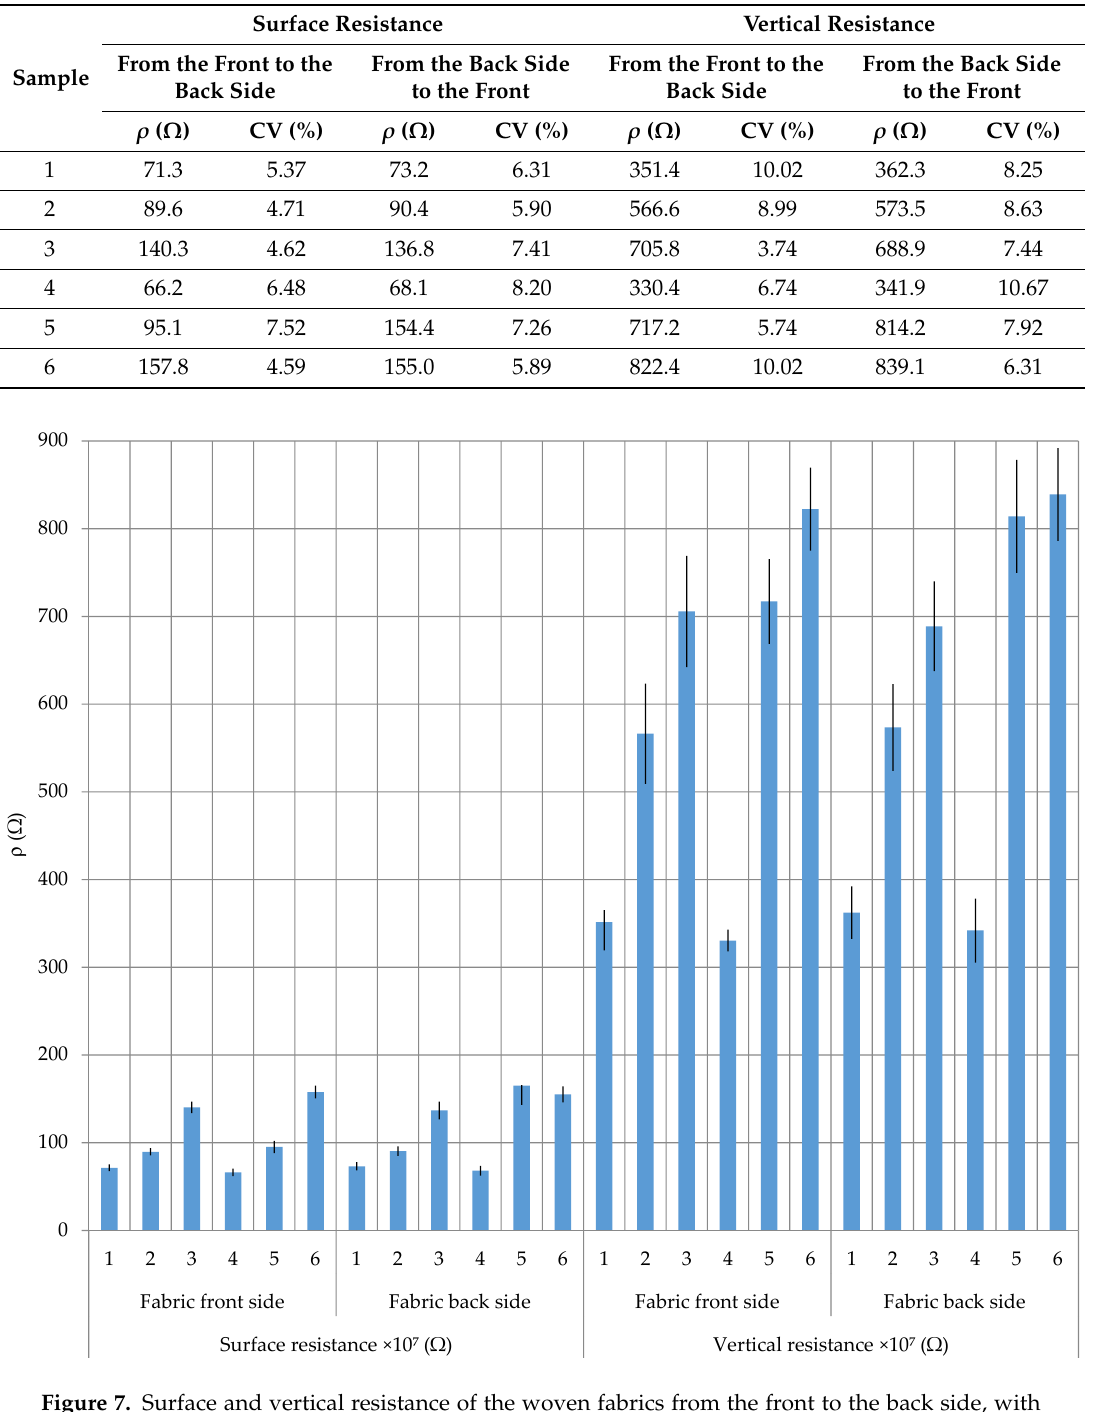
Table 6. Surface and vertical electrostatic resistance of the woven fabric measured from front to the back side.